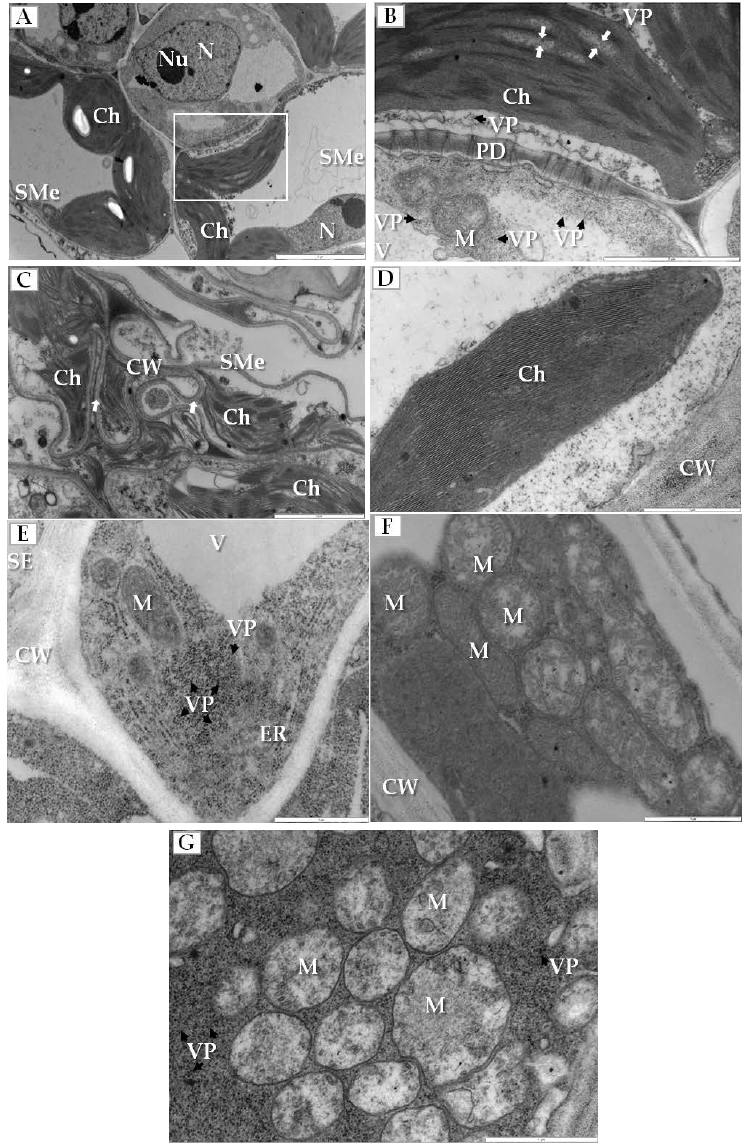
Figure 3. Ultrastructural alterations in cucumber organelles and cell wall during PDV infection. ( A ) Section through the PDV-infected leaf blade, with spongy mesophyll cells with changed chloroplasts. The white framed area is enlarged in ( B ), Bar 5 µm; ( B ) Spongy mesophyll cell from ( A ) with electron translucent regions in the stroma between thylakoids (white arrow) and also with viral particles present (VP, black arrow), Bar 2 µm; ( C ) Altered spongy mesophyll cell from infected cucumber with disintegrated chloroplasts and the cell wall irregular and deformed (white arrow), Bar 2 µm; ( D ) Parenchyma cell of from mock-inoculated cucumber without altered chloroplast and cell wall, Bar 1 µm; ( E ) Companion cell from infected cucumber with enlarged endoplasmic reticulum cisterns and the PDV particles present in cytoplasm (VP, black arrow), Bar 1 µm; ( F ) Fragment of a companion cell from infected cucumber showing mitochondria with reduced cristae and large electron translucent regions- early stage of mitochondrial changes, Bar 1 µm; ( G ) Region in the cytoplasm of a companion cell filled with PDV particles (VP, black arrow), and with no cristae in the mitochondria, Bar 1µm.